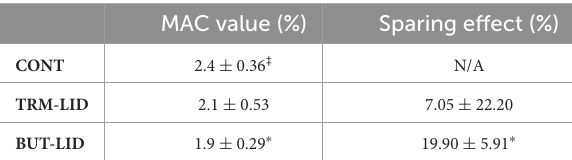
TABLE 1 Mean ± SD MAC values (%) and degree of sparing effect (%) in control (CONT), tramadol-lidocaine (TRM-LID), butorphanol-lidocaine (BUT-LID) treatments obtained from 10 female dogs in each